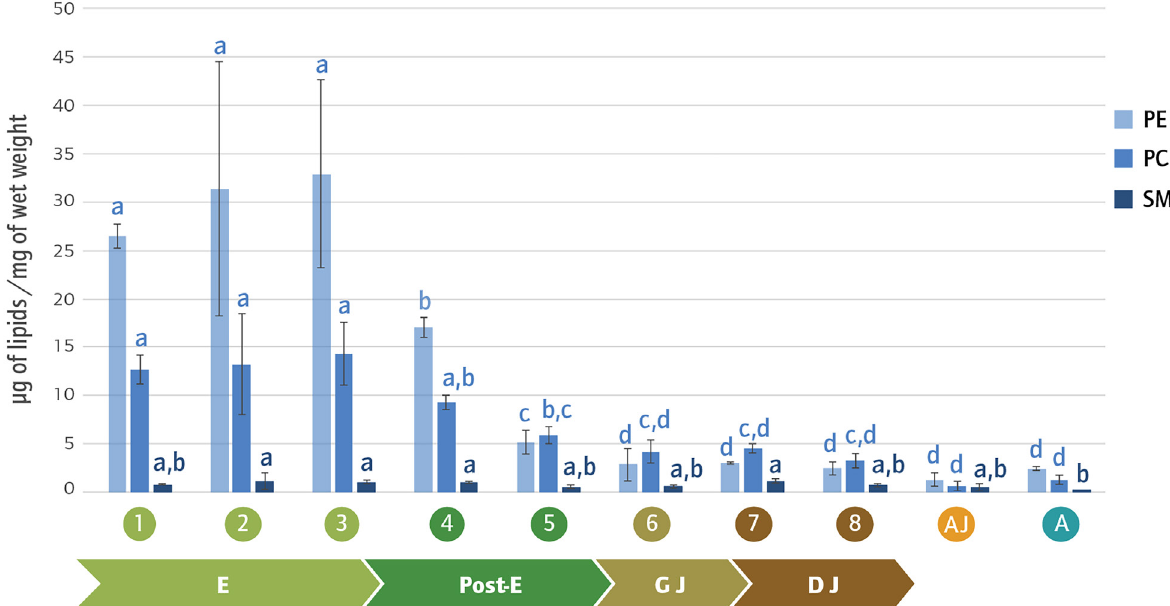
Figure 8. Concentration of the main phospholipids during P. pythagoricus development until adult’s stage: phosphatidylethanolamine (PE), phosphatidylcholine (PC) and sphingomyelin (SM). Values are the means ± SDs. Different letters above the bars indicate significant differences among the different stages at p < 0.05, as determined by Tukey’s post hoc test. 1 to 8: stages of P. pythagoricus development; AJ: advanced juvenile stage; A: adult stage; E: embryonic period; Post-E: post-embryonic period; GJ: juveniles in gregarious stage; DJ: juveniles in dispersal